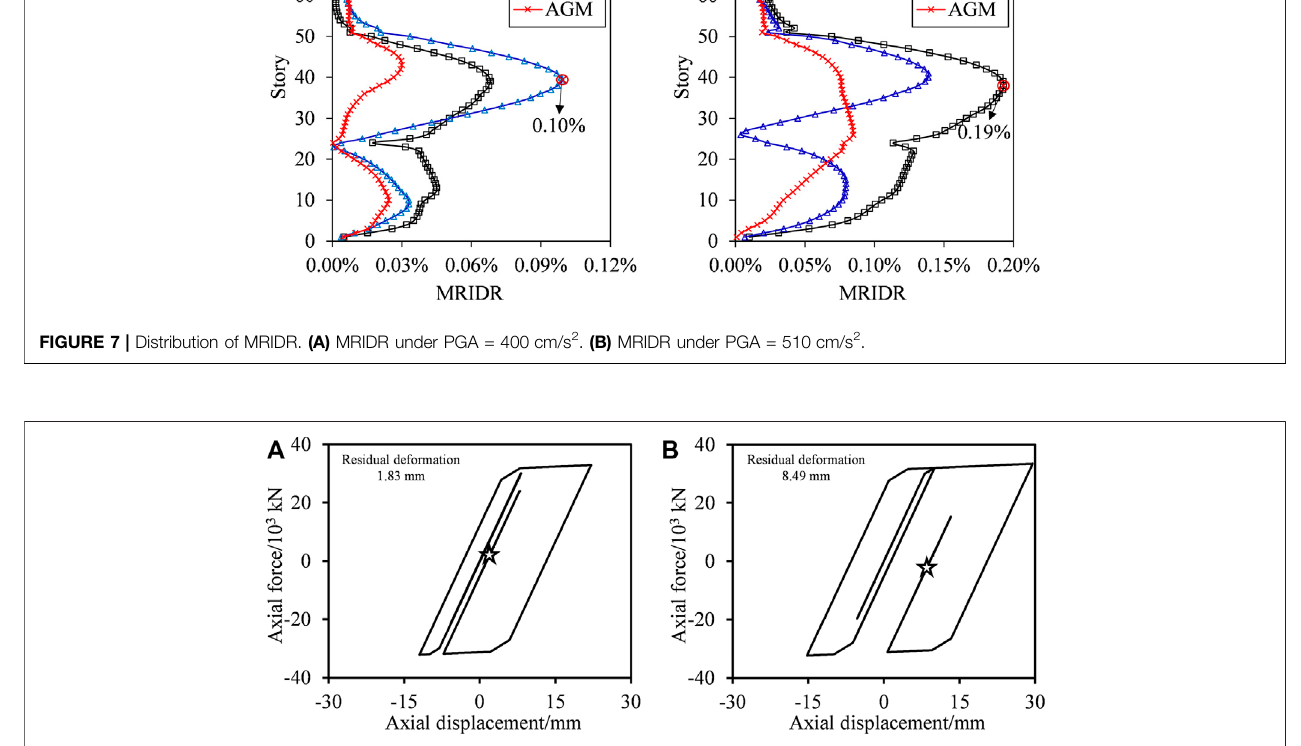
FIGURE 8 | Load-displacement hysteretic curves of BRB in the 24 th story under NGM1. (A) PGA = 400 cm/s 2 . (B) PGA = 510 cm/s 2 .